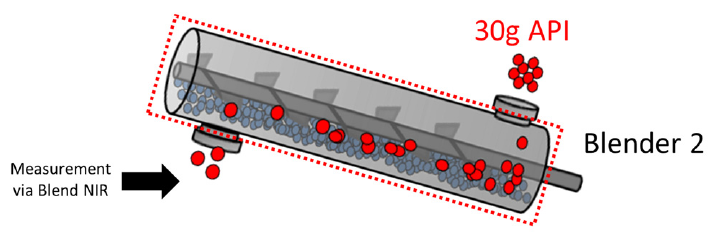
Figure 2. Graphical Representation of a Blender 2 Impulse Experiment.